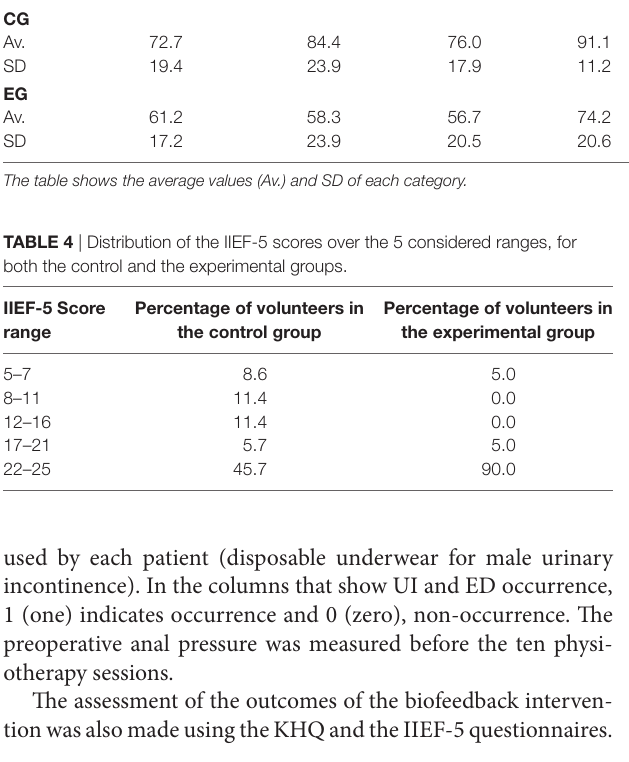
tABLe 3 | Statistical summary of the results of the KHQ applied to the control group (CG) and experimental group (EG), in terms of the scores related to the different considered areas. Patient general health perceptions Cg Av.